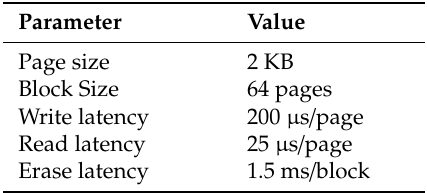
Table 1. Parameters of the NAND flash memory.